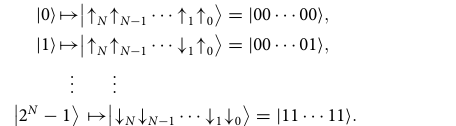
(cid:1) (cid:3) ^ a y 2 s and (cid:1)